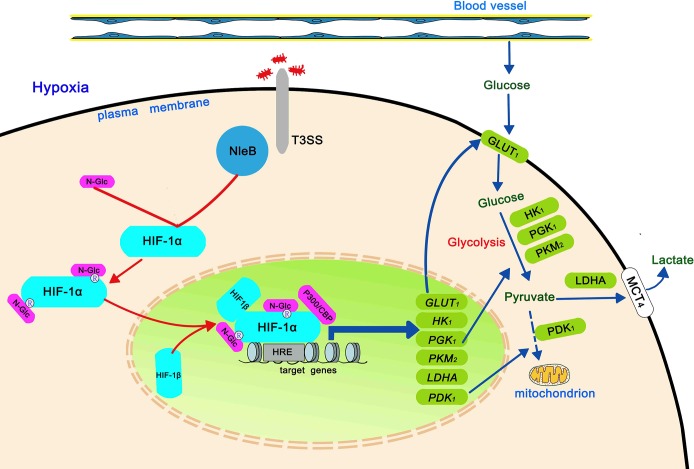
Working model for the role of NleB in host glucose metabolism.Host intestinal epithelial cells maintain low O2 conditions due to counter-current blood flow. When bacteria such as EPEC infect intestinal epithelial cells, the T3SS delivers NleB into them, then NleB binds and GlcNAcylates HIF-1α at arginine residues, enhancing HIF-1α transcriptional activity and increasing the expression of downstream glucose metabolism-associated gene targets to modulate processes related to glucose uptake (GLUT1) and glycolysis (HK1, PGK1, PKM2, LDHA, and PDK1).